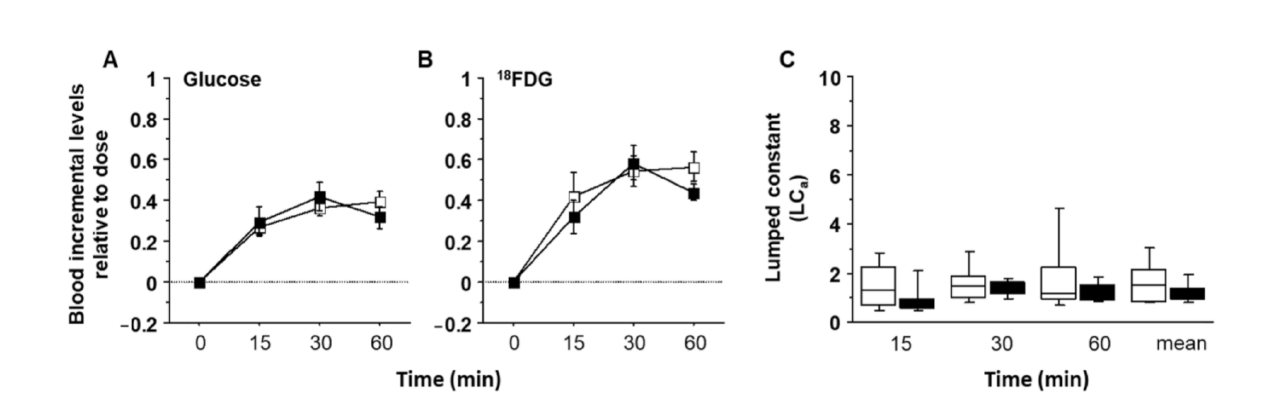
Figure 3. Lumped constant for GI absorption: Time course of dose-normalized increments in blood glucose and 18 FDG activity levels ( A , B ). Panel ( C ) shows stability over time and between groups of the FDG-to-glucose GI absorption ratio, with LCa = 1.18 as median